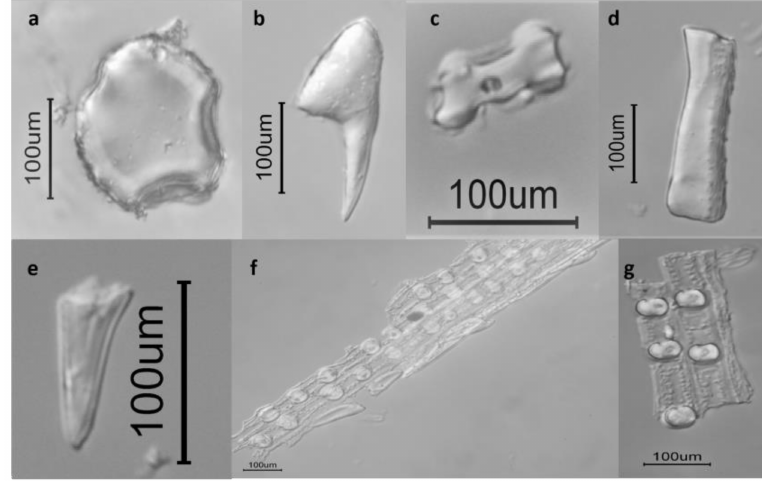
Figure 4. Phytolith extracted from tillers of Eragrostis curvula : ( a ) cuneiform bulliform cell, ( b ) uniform hair cell, ( c ) bilobate short cell, ( d ) elongate entire cylindric, ( e ) acicular hair cell, ( f ) ovate cell, ( g ) short saddle-shaped